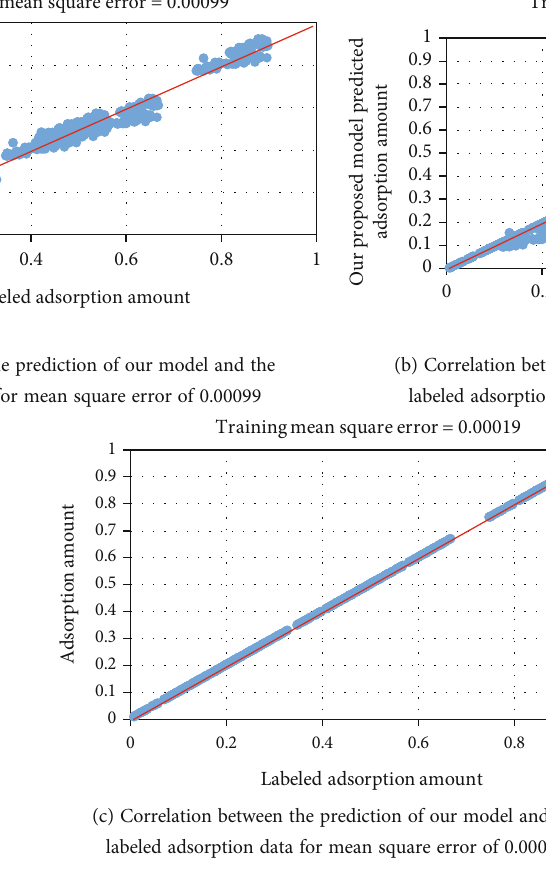
Figure 7: Correlation between the prediction of our model and the benchmark data for di ff erent mean square error versus the ground truth (labeled adsorption